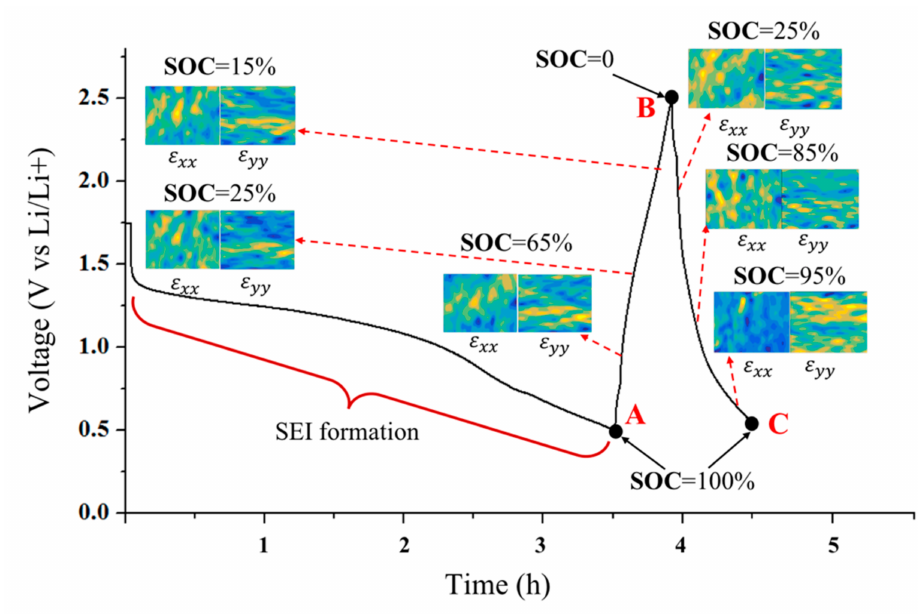
Figure 5. Electrode deformation distributions of the